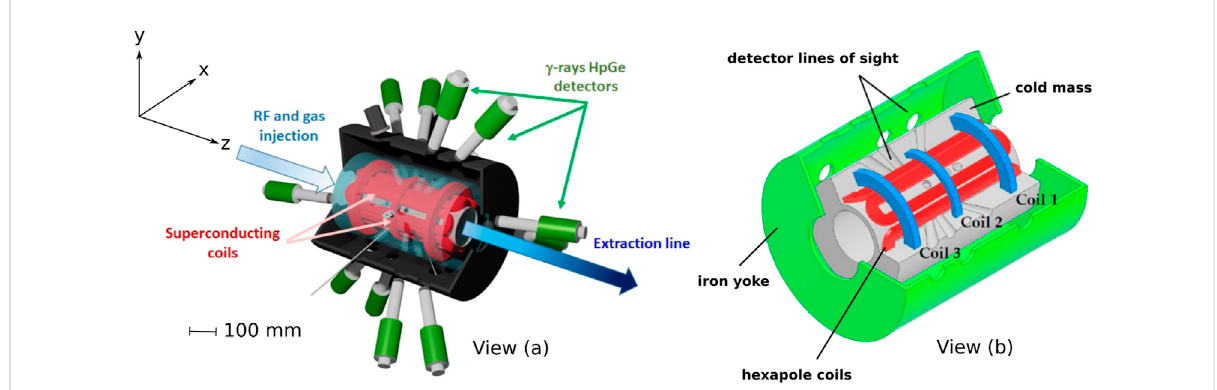
FIGURE 1 SchematicsofthePANDORAchamber,inwhichanelectroncyclotronresonanceplasmawillbecreated.View (A) showsasectionalviewofthe full experiment. View (B) shows details of the magnetic fi eld con fi guration and its integration into the cold mass. Views (A,B) show the external iron yoke enclosing the plasma chamber, hexapoles (in red) and solenoids (in blue), and the cold mass in which the magnets are to be embedded. The lines of sight for γ -ray detectors and other diagnostics are also shown. Images have been adapted from (Mascali et al., 2022). A coordinate system has been de fi ned in which z is coincident with the chamber axis and x and y are directions orthogonal to z